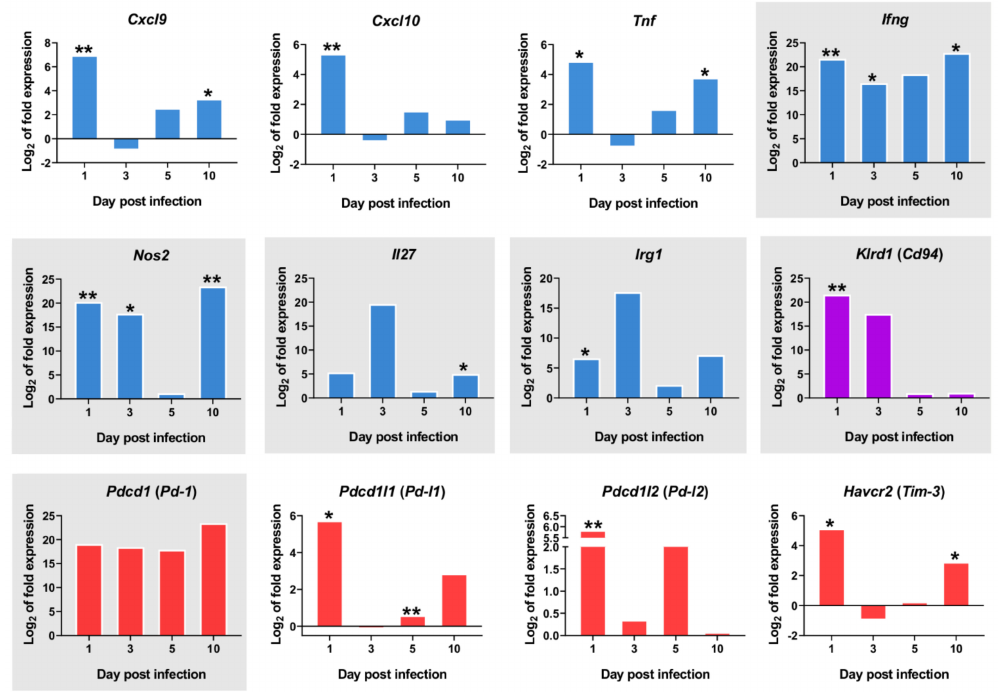
Figure 4. mRNA expression of important markers overtime. The y-axis represents log 2 of expression fold-change for each indicated gene, that is the ratio between the average gene expression in the infected group and non-infected-control